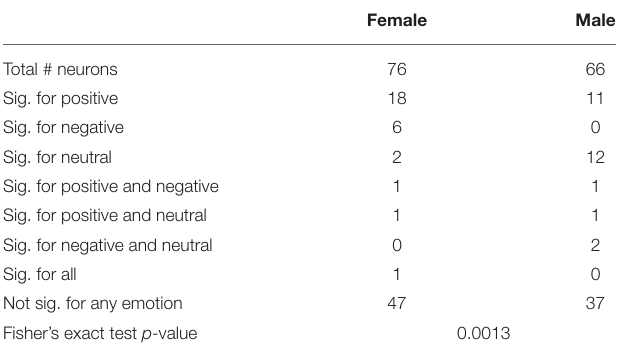
TABLE 6 | Neurons significant for specific emotions relative to background firing in left